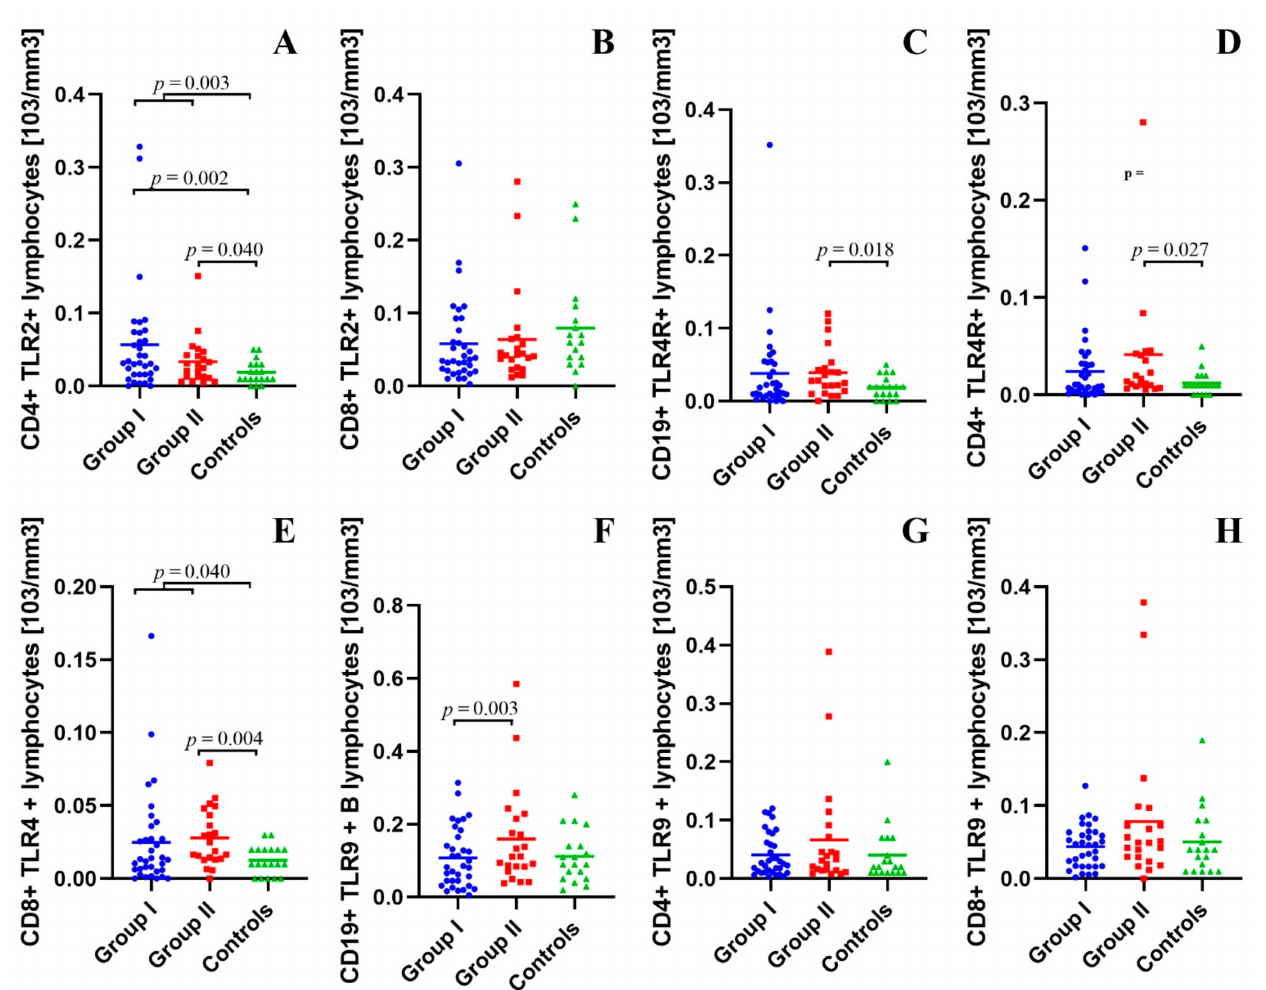
Figure 1. ( A – H ). Assessment of B CD19+, T CD4+, and T CD8+ lymphocytes with TLR2, TLR4, TLR9 expression in the study and control